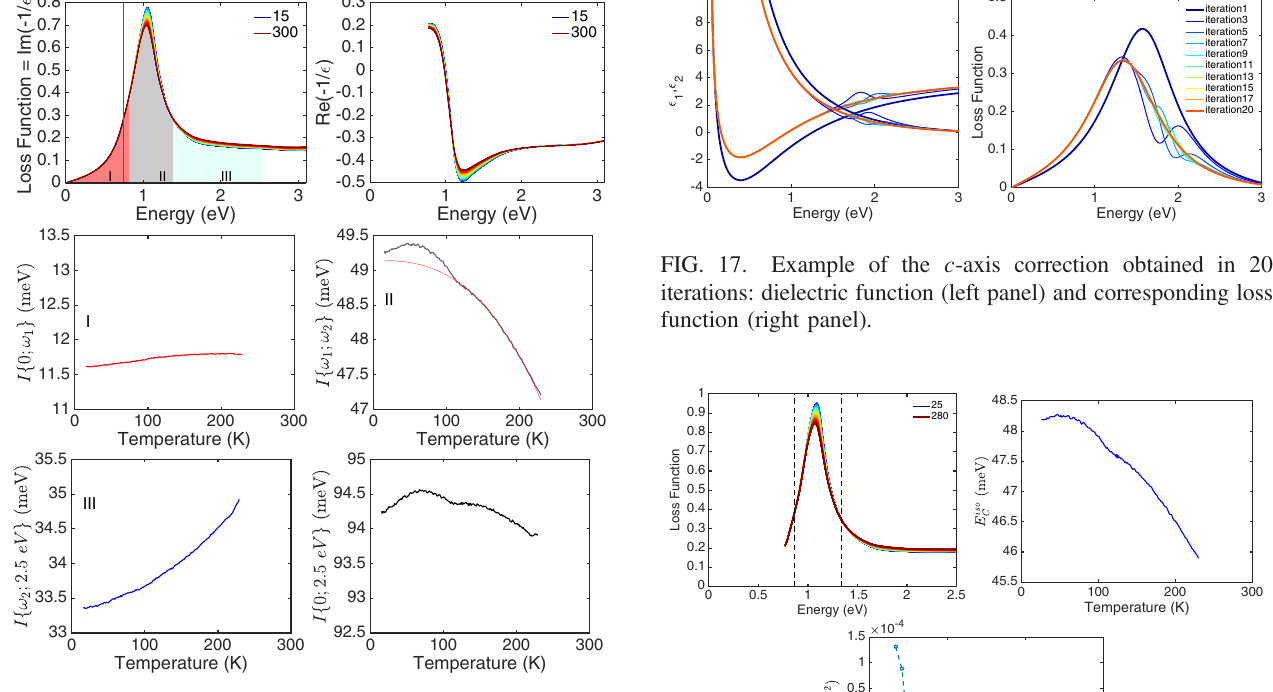
FIG. 16. Sample Bi2223-110-OP. Caption details as in Fig. 8. The value of the fitted exponent α is 2.7. The evolution as a function of temperature above 220 K was not fully reproducible because of a combination of factors having to do with small crystal size and instrument drift. The temperature range for this sample is therefore limited below 220 K.